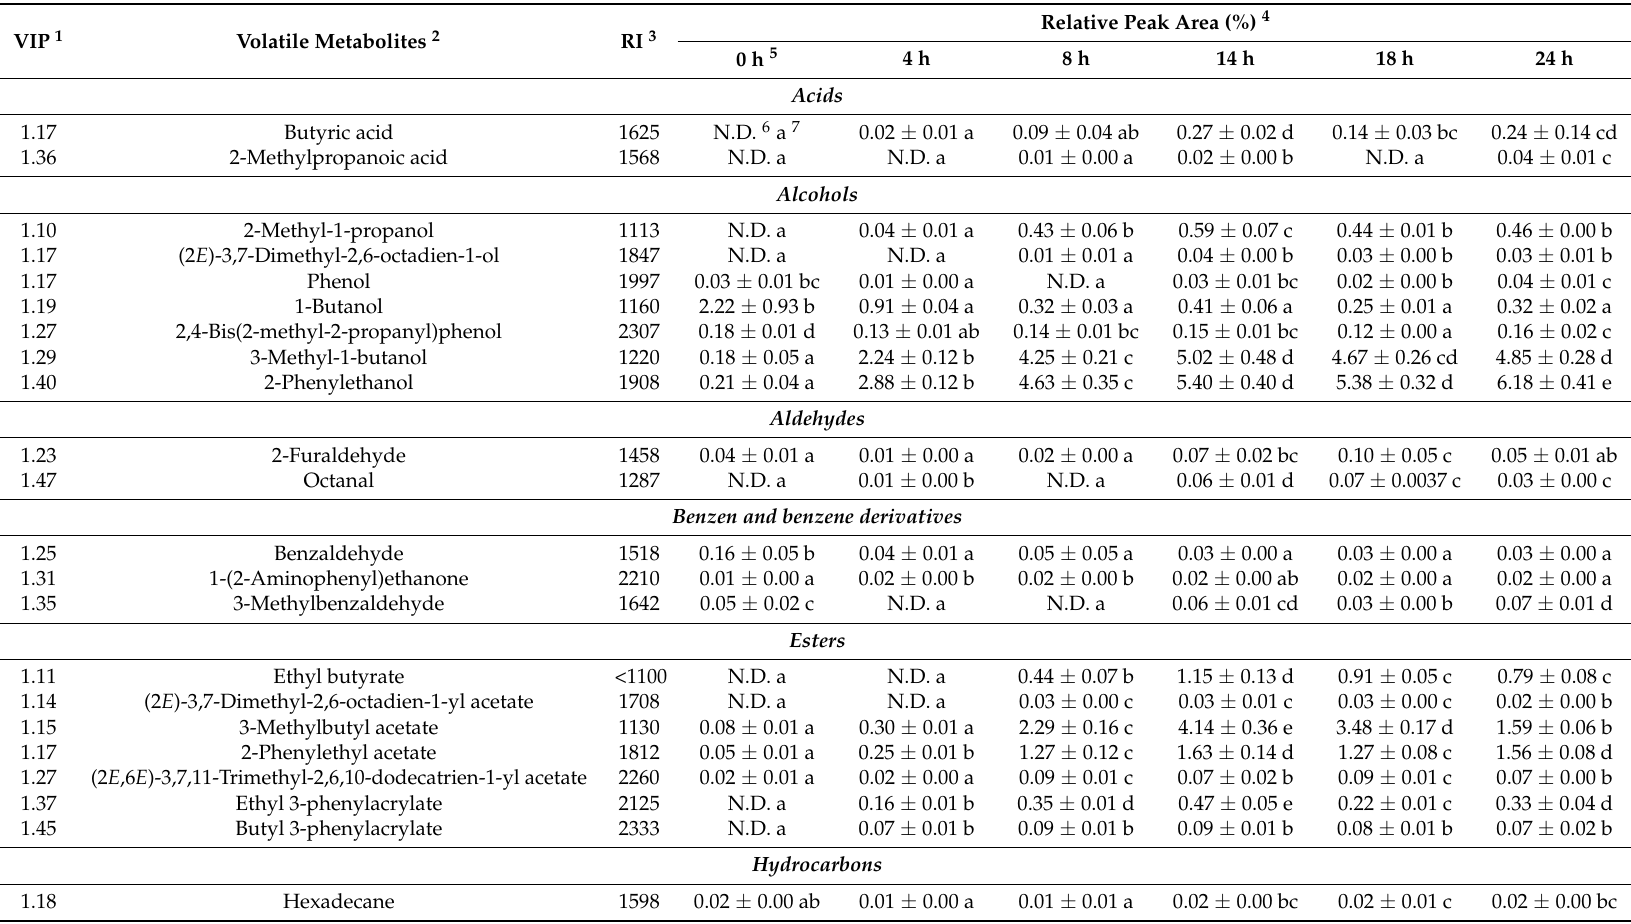
Table 2. Volatile metabolites identified in S. fibuligera KJJ81 according to cultivation